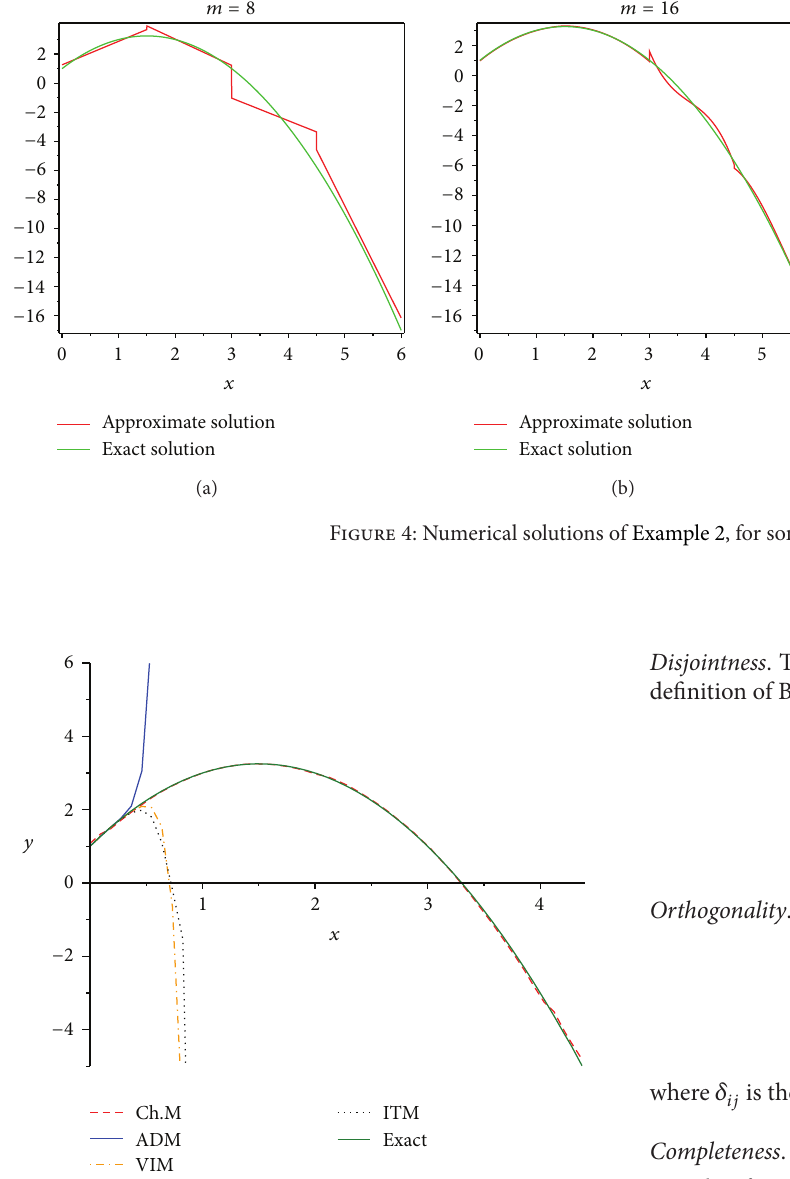
Figure 5: Numerical solutions of Example 2 for 𝛼 = 0.85